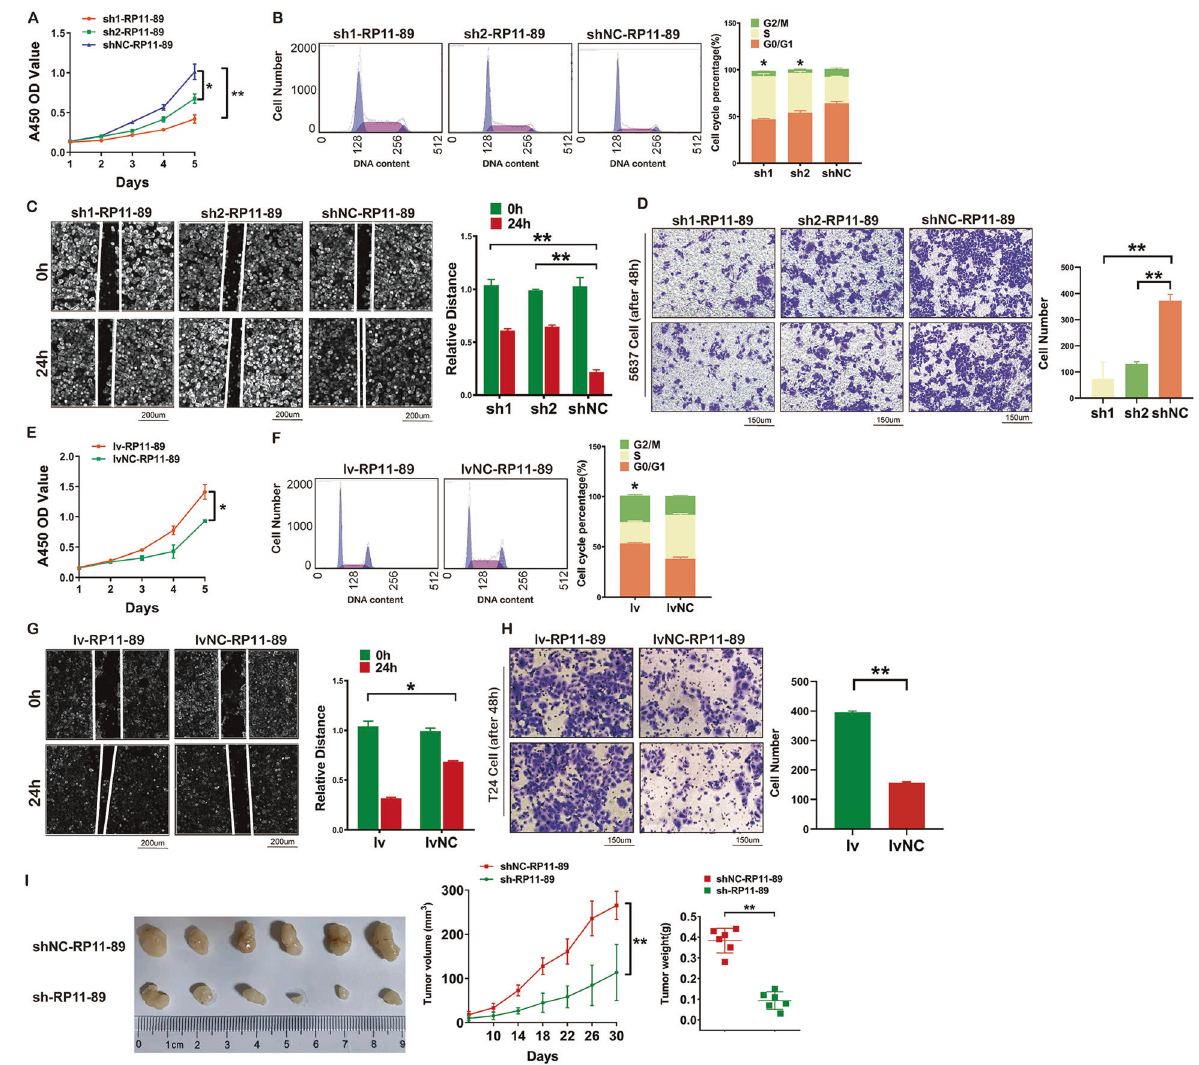
Fig. 2 RP11-89 functions as an oncogene in BLCA. A , E Cell proliferation of BLCA cells with RP11-89 knockdown ( A ) and overexpression ( E ) was assessed by CCK-8 assay. B , F Cell cycle analysis showed the percentage of G2/M phase, S phase, and G0/G1 phase cells of BLCA cell lines with RP11-89 knockdown ( B ) and overexpression ( F ). C , G Scratch assays evaluated the migration ability of 5637 Cell with RP11-89 knockdown ( C ) and T24 Cell with RP11-89 overexpression ( G ). D , H Transwell assays con fi rmed that migration ability of BLCA cell line was suppressed with RP11-89 knockdown ( D ) and enhanced with RP11-89 overexpression ( H ). I Representative images of tumors from nude mice inoculated with BLCA cells and RP11-89 knockdown decreased tumor volume and tumor weight of nude mice after inoculation. Results are presented as mean ± SD. * P < 0.05; ** P < 0.01, *** P < 0.001, **** P < 0.0001. Data were obtained from at least three independent experiments.